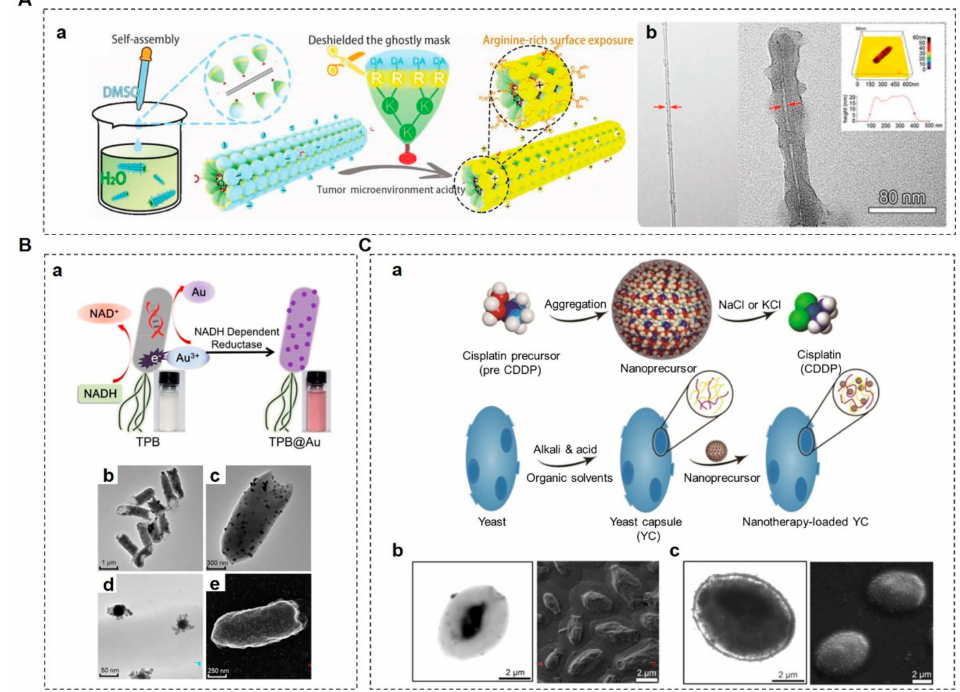
Figure 4. Pathogen-based drug delivery systems. ( A ). Construction of an artificial tobacco mo- saic virus (ATMV). ( Aa ) Schematic illustration of supramolecular assembly fabrication of ATMVs. ( Ab ) TEM images of a single-walled carbon nanotube (SWNT) which was conjugated with an